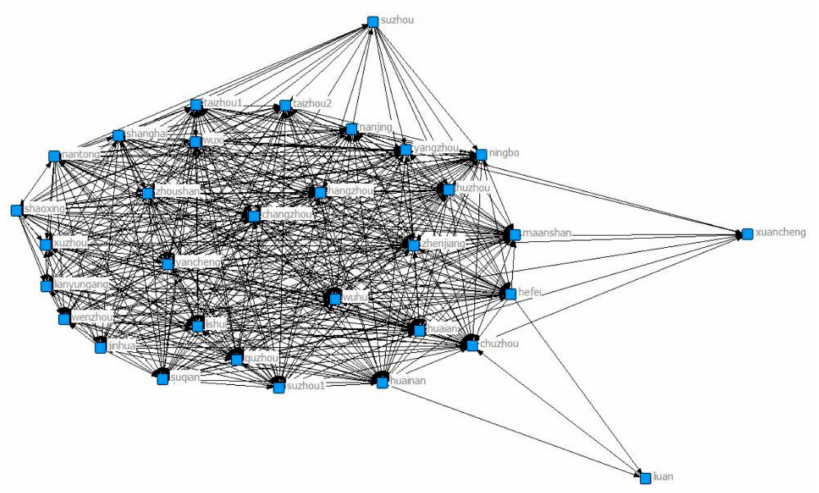
Figure 7. Yangtze River Delta collaborative network in